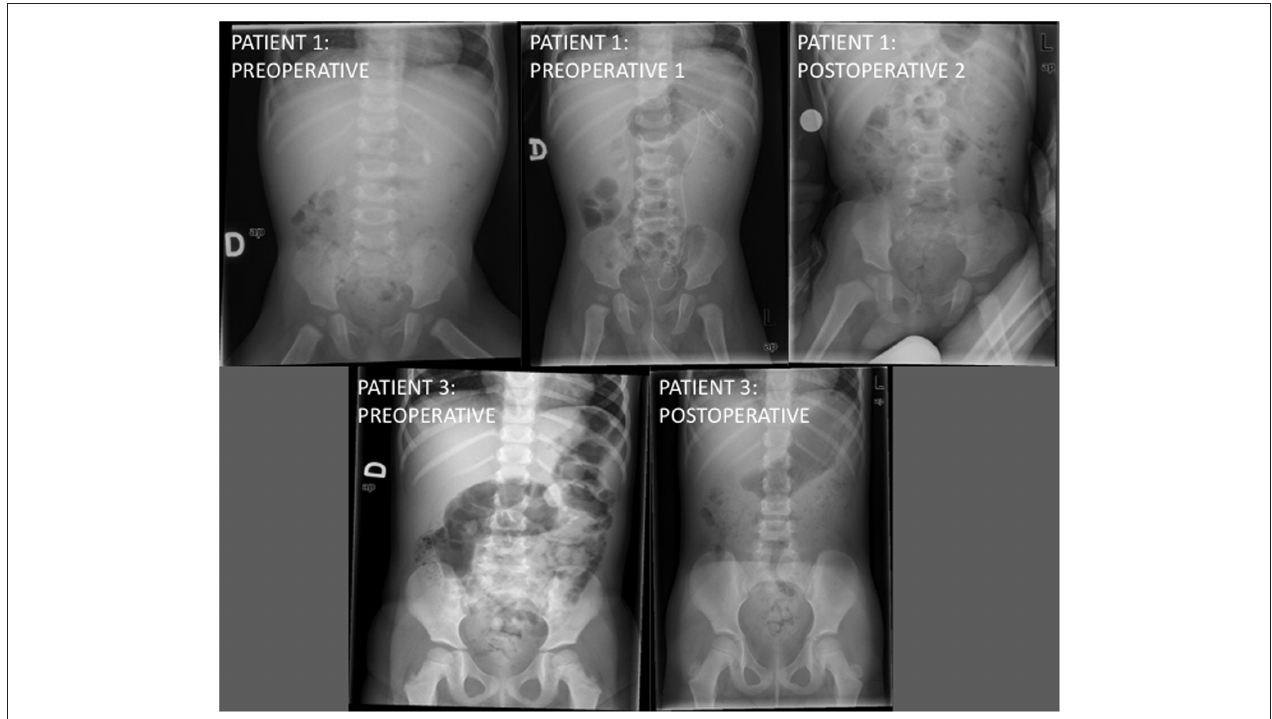
FIGURE 1 | Radiological images of the first and third patients before and after